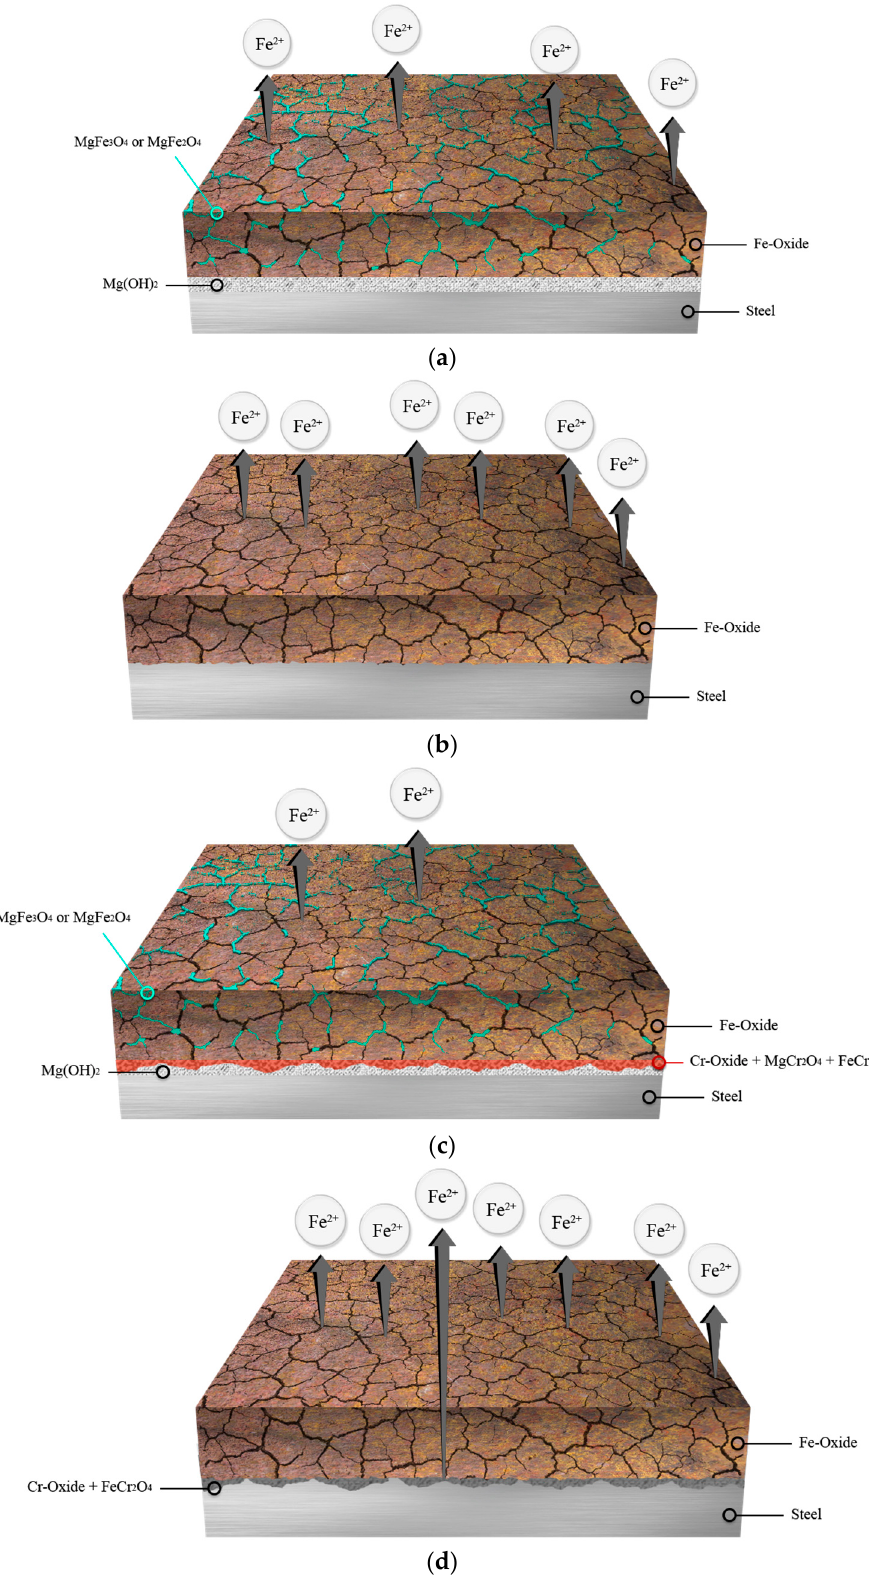
Figure 10. Schematic diagrams of corrosion products on specimens after 30 days immersion in seawater: ( a ) blank steel in seawater; ( b ) blank steel in Mg 2+ ions-free seawater; ( c ) 0.7-wt.%-Cr steel in seawater and ( d ) 0.7-wt.%-Cr steel in Mg 2+ ion-free seawater.